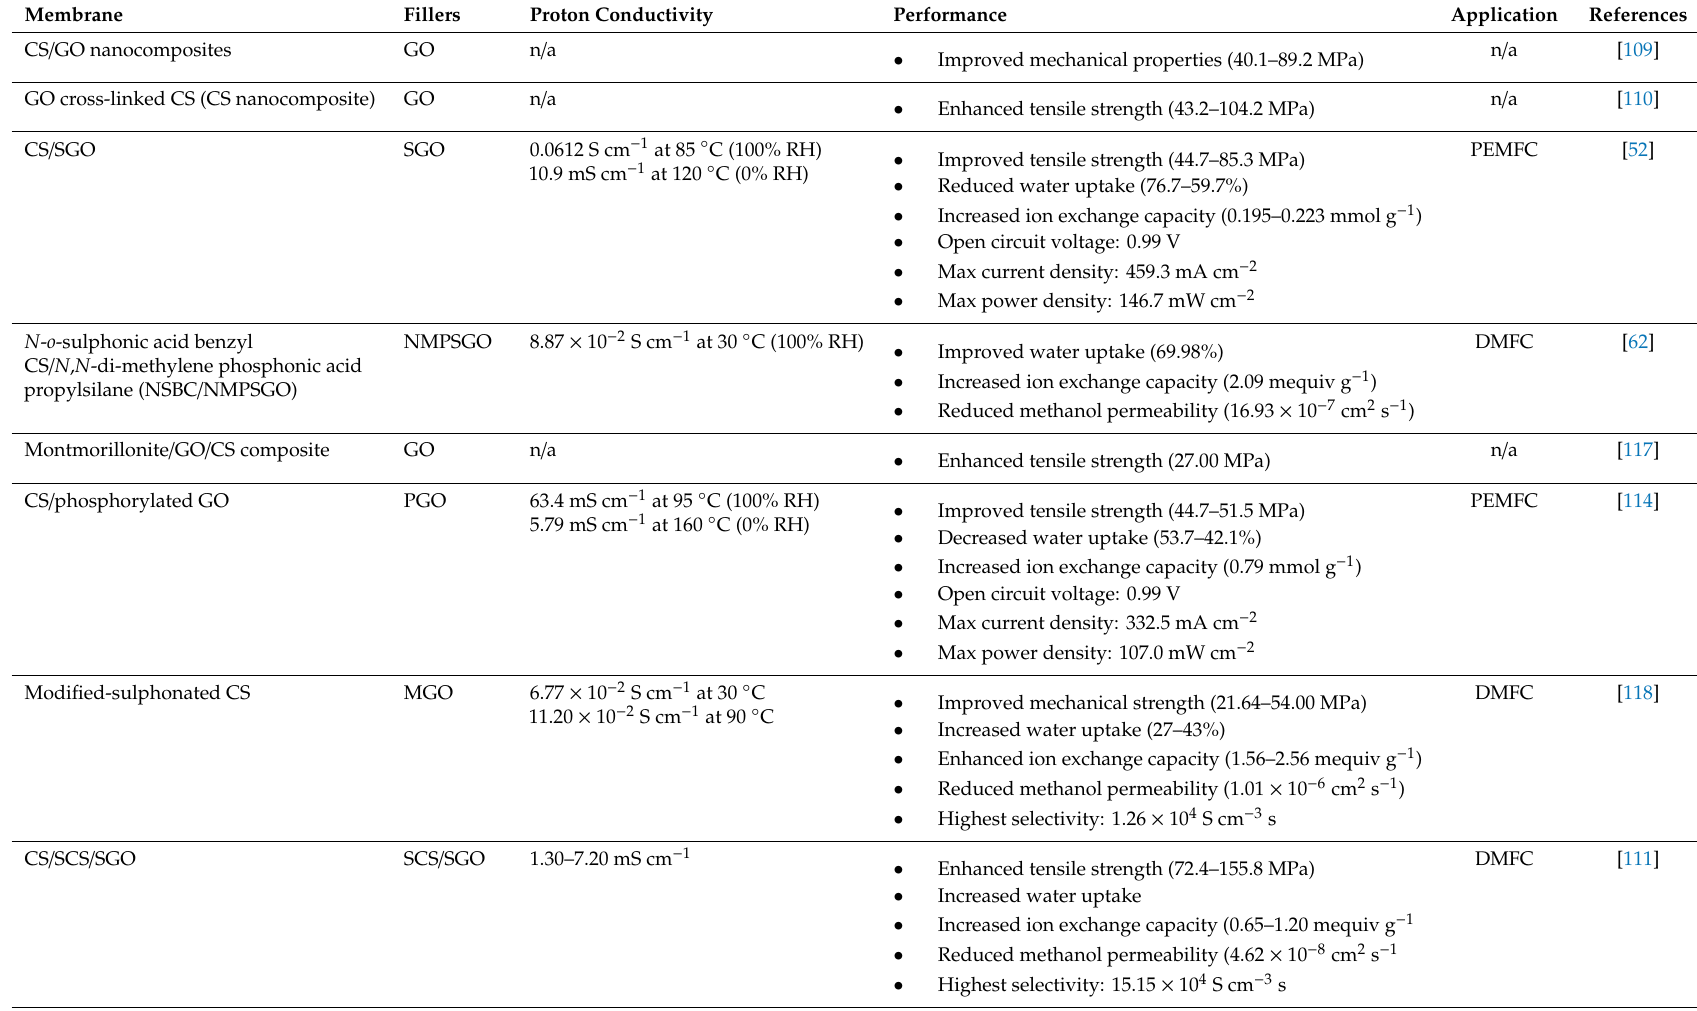
Table 4. Applications of graphene oxide (GO) in CS hybrid